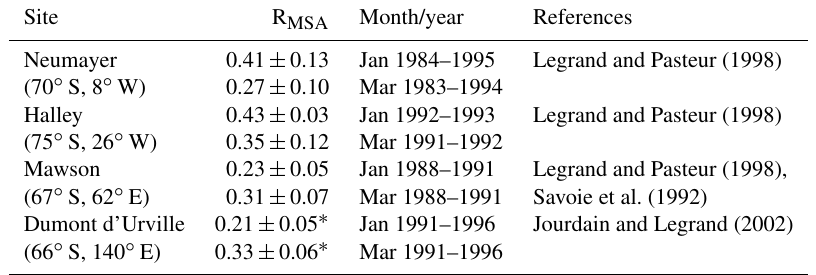
Table 5. MSA / nssSO 4 ratios (R MSA ) observed at coastal Antarctic sites in January and March: Neumayer and Halley facing the Atlantic ocean and Dumont d’Urville and Mawson the Indian